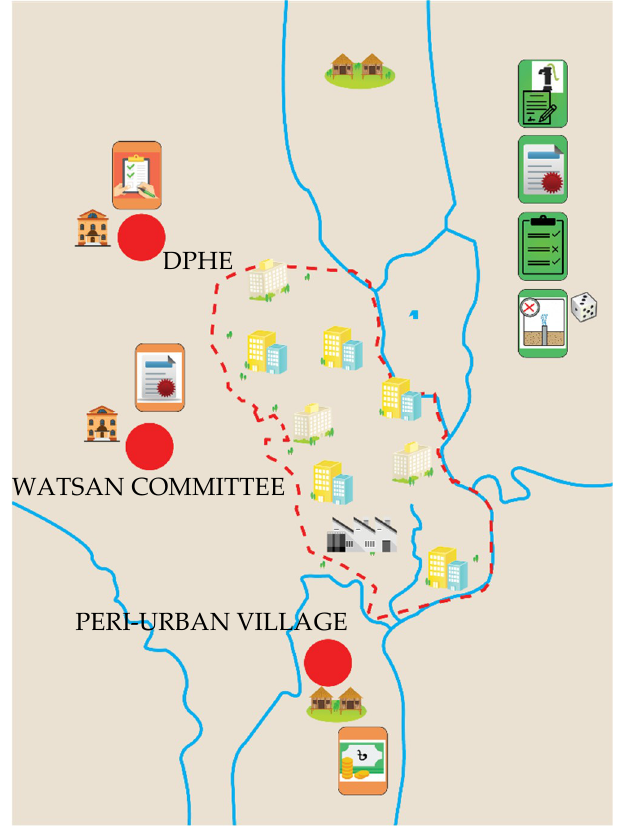
Figure 4. Game play in round 1 (Game 1).